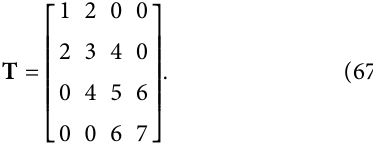
Figure 7: For Example 5, showing four picks of ‖ x ‖ , corresponding to eigenvalues − 2.4848, 0.7046, 4.9366, and